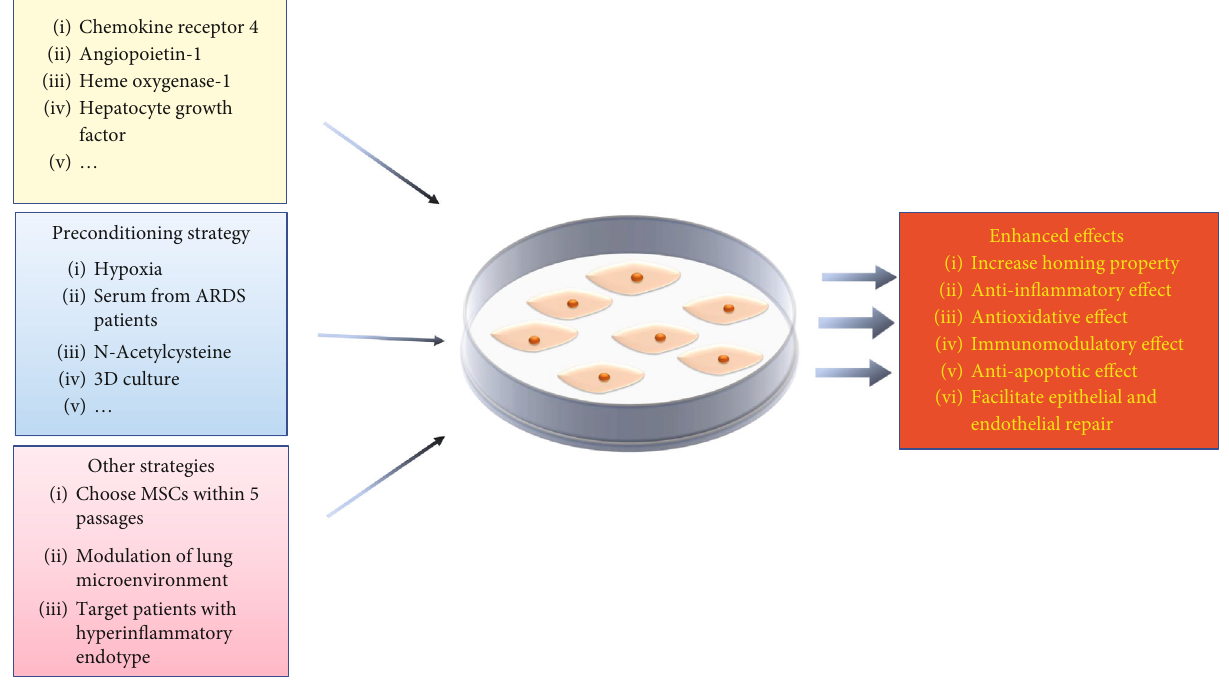
Figure 1: Schematic representation of the main strategies to enhance MSC therapeutic potential for